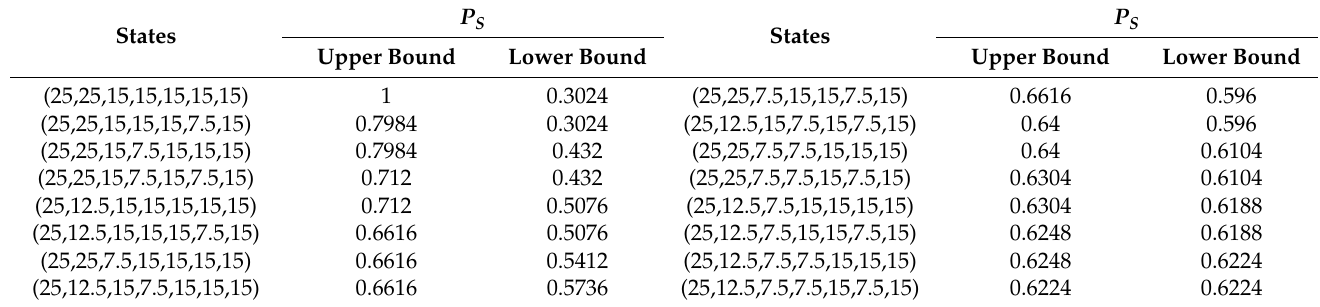
Table 6. Reliability upper and lower bounds analysis based on road network